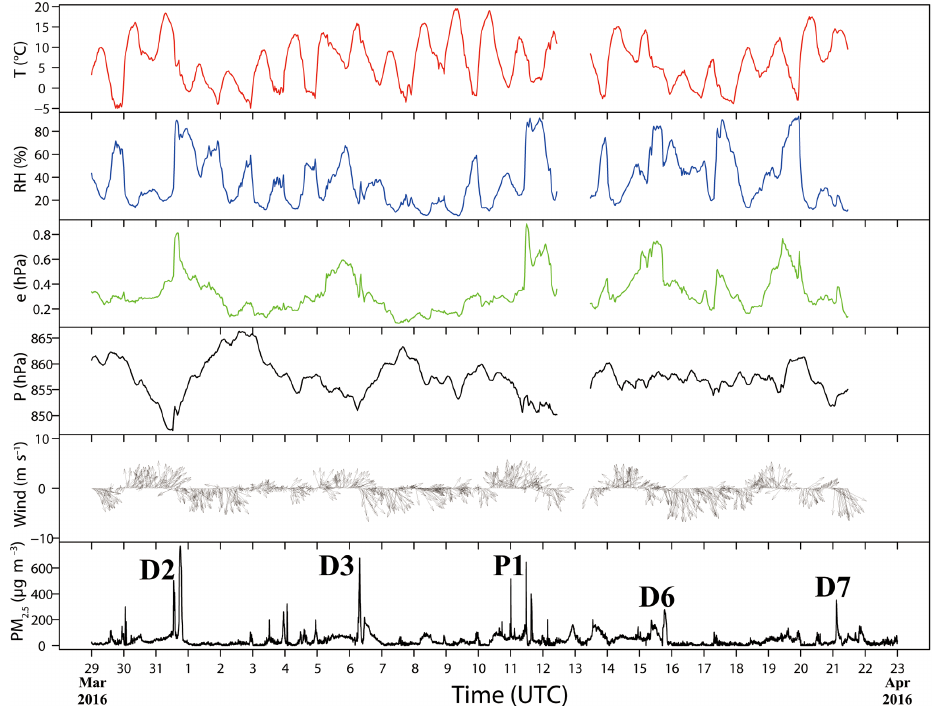
Figure 3. Meteorological conditions and air quality measurements during the sampling period. T : temperature; RH: relative humidity; e : water vapor pressure; P : atmospheric pressure. D1–D7 correspond to the seven dust events that occurred in Erenhot.